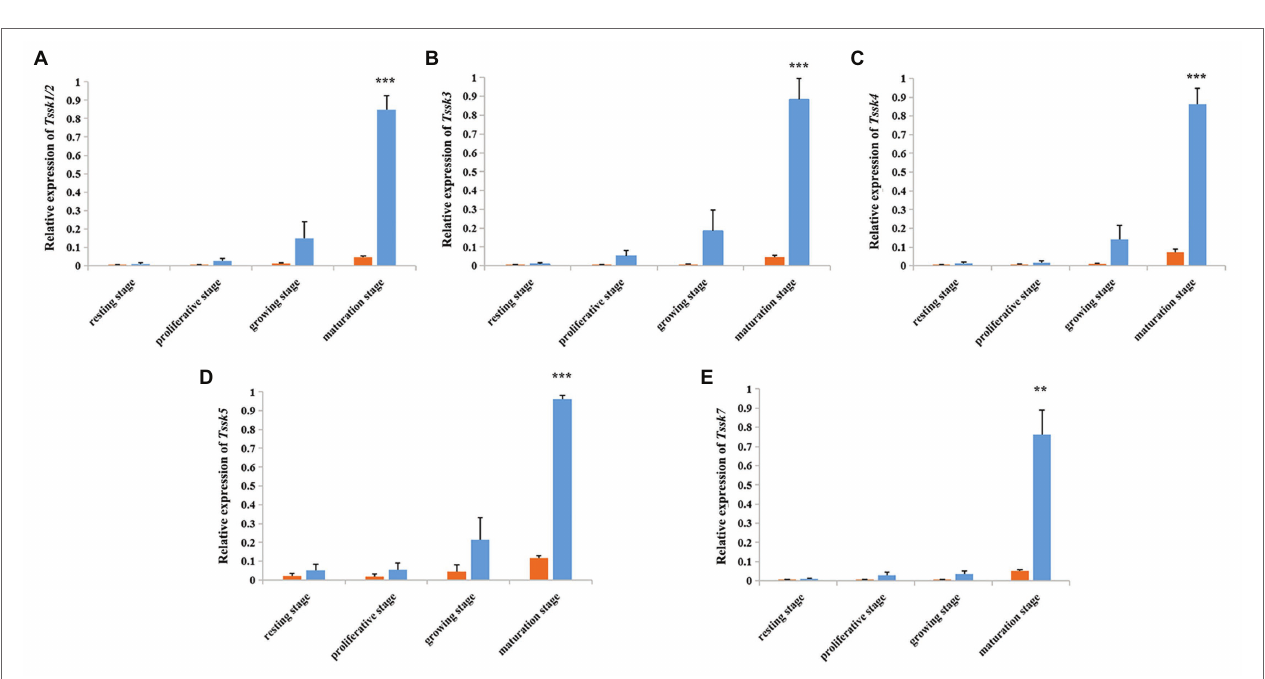
FIGURE 4 | Temporal expression profile of five A. irradians Tssk genes in ovaries (orange) and testes (blue) during the gametogenic cycle. (A–E) Represent Tssk1/2, Tssk3, Tssk4, Tssk5, and Tssk7, respectively. Significant differences: ** p < 0.01; *** p <